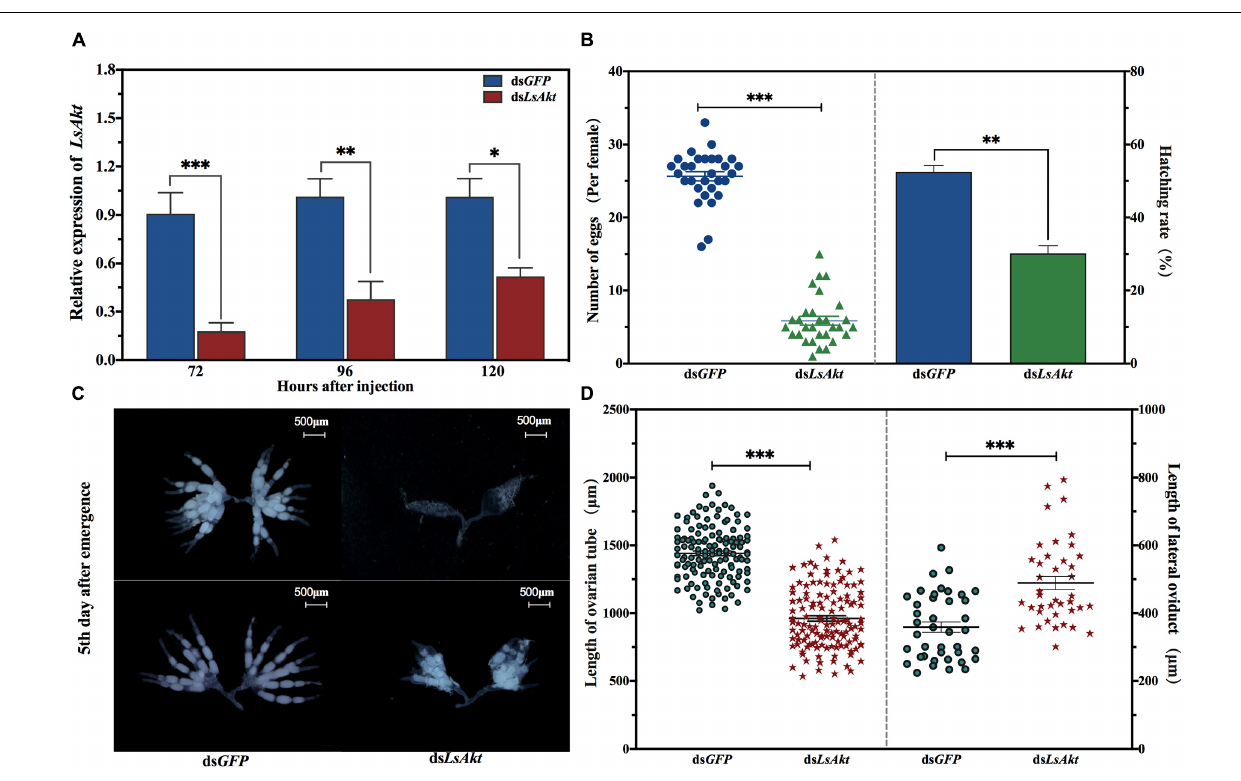
FIGURE 4 | Effect of LsAkt RNAi on female reproduction in L. serricorne . (A) Relative expression levels of LsAkt at 72, 96, and 120 h after LsAkt or GFP dsRNA injection. (B) Determination of female fecundity after LsAkt knockdown. (C) Ovary morphology after LsAkt knockdown. Day-3 female pupae were injected with LsAkt or GFP dsRNA. Ovaries were dissected and photographed on the fifth day after adult eclosion. (D) Effects of LsAkt knockdown on the lengths of ovarian tube and lateral oviduct. Significant differences between the RNAi group and control group were determined using Student’s t -test ( ∗ P < 0.05, ∗∗ P < 0.01, ∗∗∗ P <